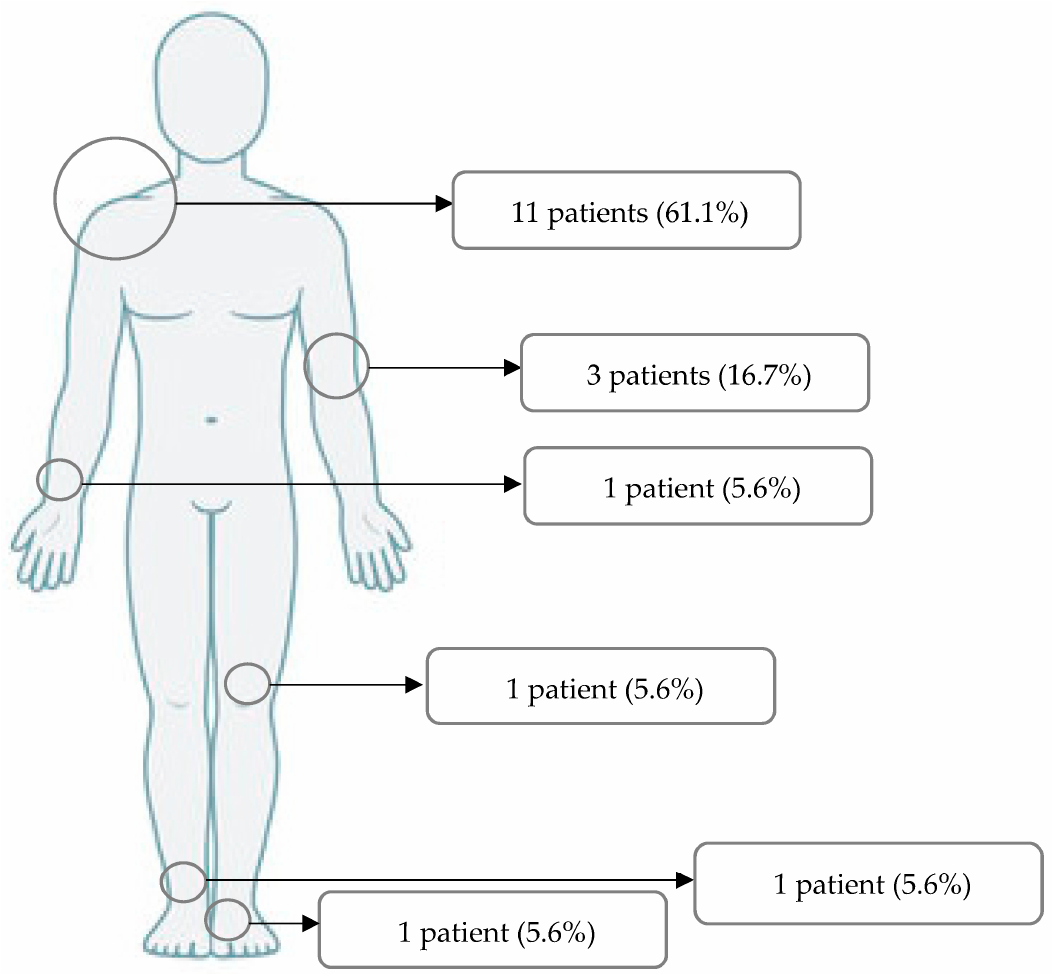
Figure 2. Regions of surgery.